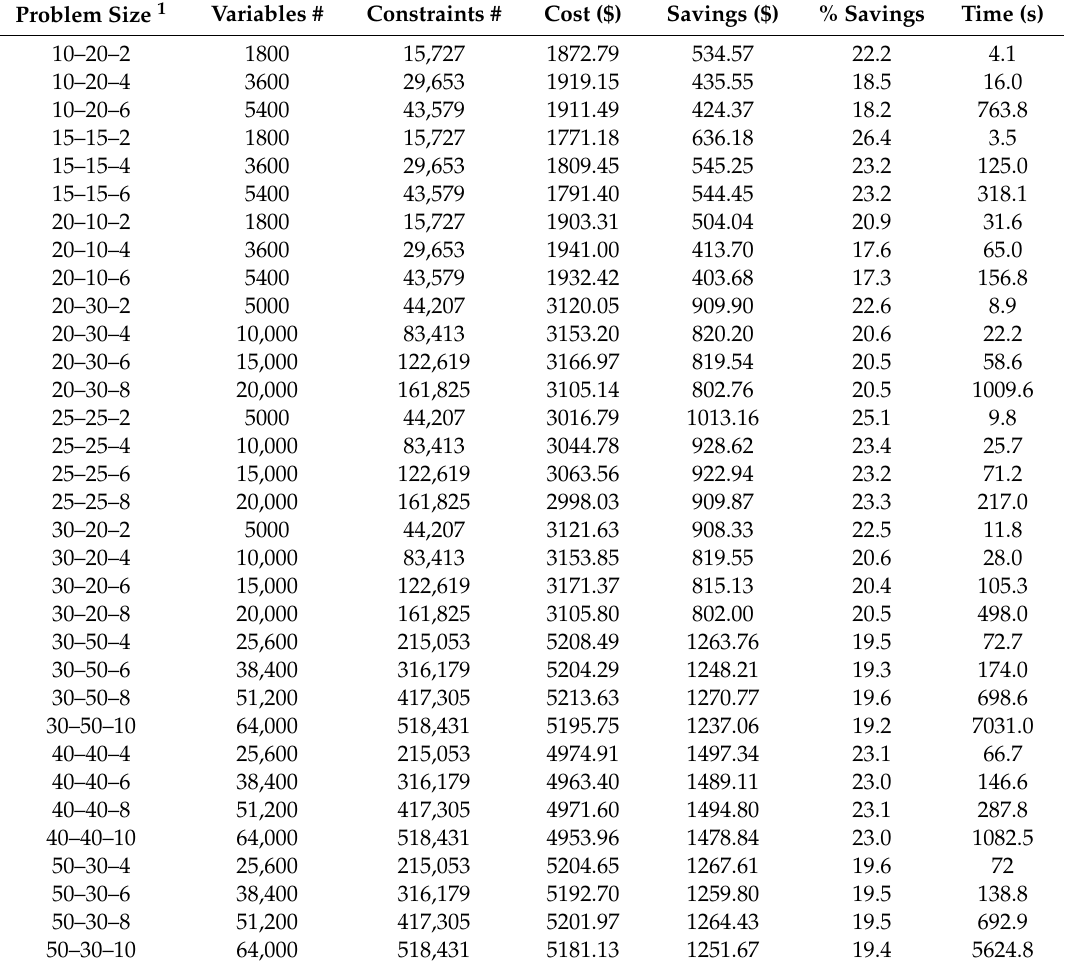
Table 6. Computation results with varying number of shipments and